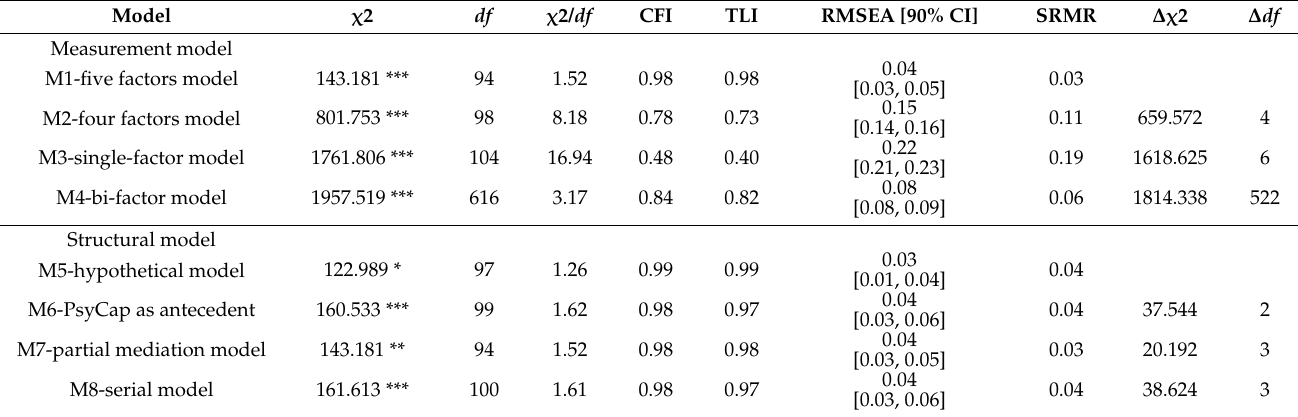
Table 2. Fit indices and model comparisons for measurement and structural